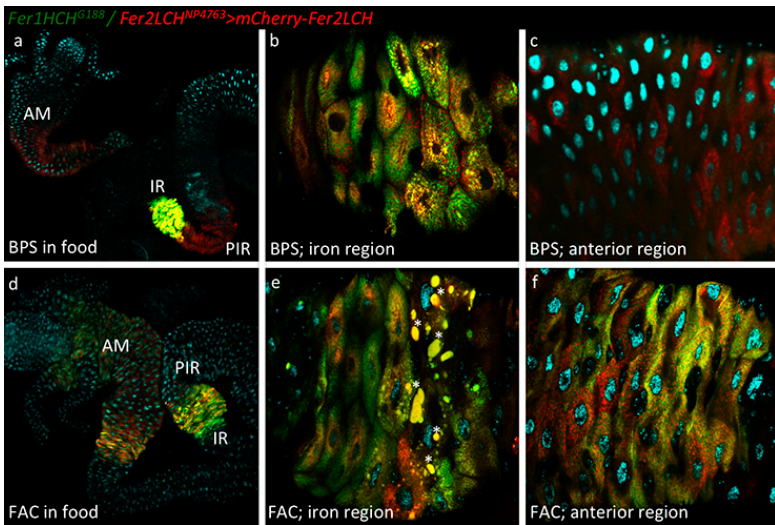
Figure 2. ( a ) Larvae of the genotype Fer1HCH G188 /Fer2LCH NP4763 , UAS-mCherry-Fer2LCH were grown on a diet supplemented with 200 µM BPS. Intestines were dissected, mounted in Vectashield with DAPI and imaged by confocal microscopy. Green fluorescence is from GFP-Fer1HCH; red fluorescence from mCherry-Fer2LCH; cyan fluorescence from DAPI. Using the 10× objective, GFP-Fer1HCH is readily observed only in the iron region (IR) as previously described. In contrast, mCherry-Fer2LCH is detected both in the iron region and in cells posterior to the iron region (PIR), recapitulating the expression pattern seen in Figure 1a, but it is also readily observable in the anterior midgut (AM); ( b ) Closer view of the iron region using the 40× objective (anterior is to the left) ( c ) and of the anterior Fer1HCH G188 / Fer2LCH NP4763 , UAS-mCherry-Fer2LCH were grown on a diet supplemented with 1